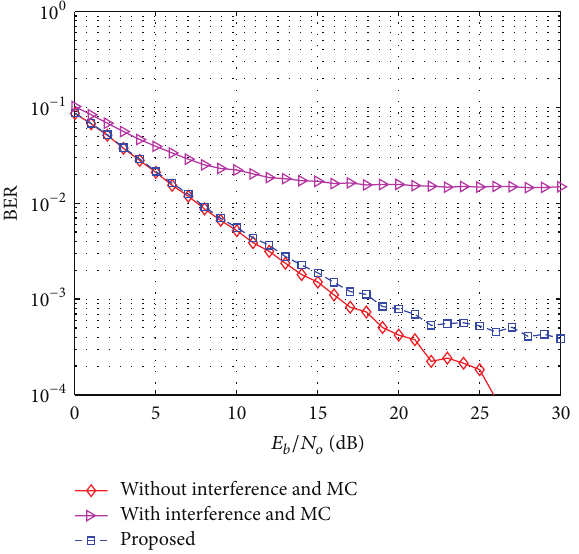
Figure 14: BER performance for 4 × 4 MIMO